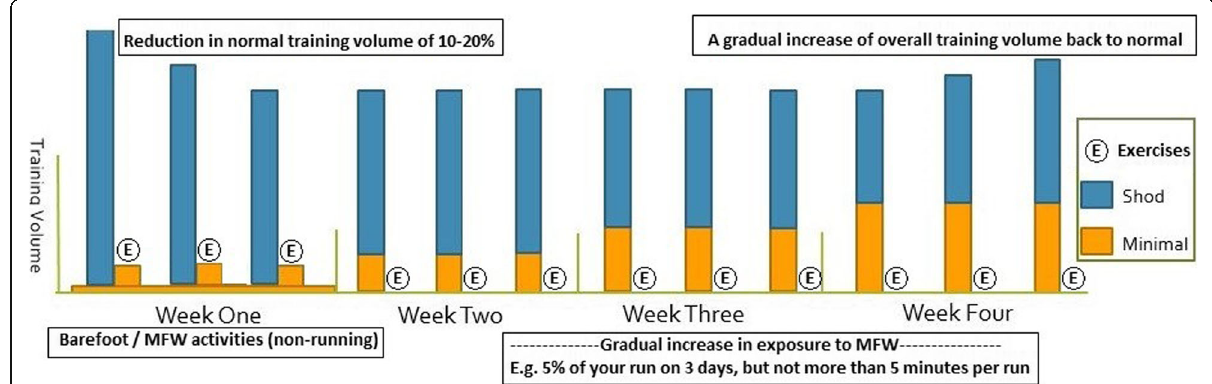
Fig. 2 A simple example of how one might structure the initial stages of a MFW transition. Note that it is not intended that a MFW transition takes place over just 4